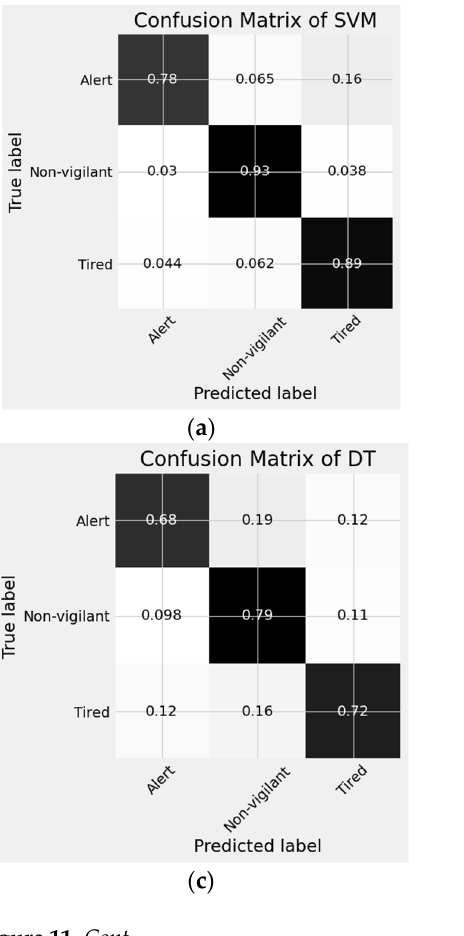
Figure 10. Binary-class learning and performance curves of the proposed machine learning models . ( a ) Learning Curve and Performance plots of The Proposed SVM Model. ( b ) Learning Curve and Performance plots of The Proposed RF Model. ( c ) Learning Curve and Performance plots of The Proposed DT Model. ( d ) Learning Curve and Performance plots of The Proposed KNN Model. ( e ) Learning Curve and Performance plots of The Proposed QDA Model. ( f ) Learning Curve and Performance plots of The Proposed MLP Model. ( g ) Learning Curve and Performance plots of The Proposed LR Model.